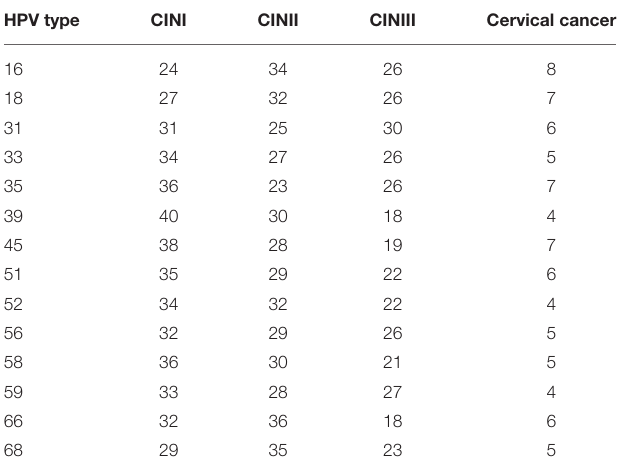
TABLE 3 | Comparison of various high-risk HPV infections in different cervical cancer